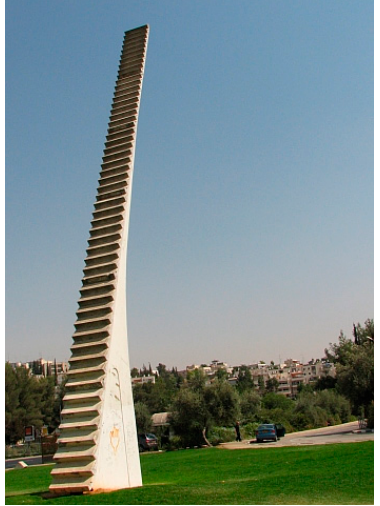
Figure 2. Ezra Orion: Ma’a lot . 1979–1980. Mixed Industrial Media (100 cm × 1050 cm). Photograph